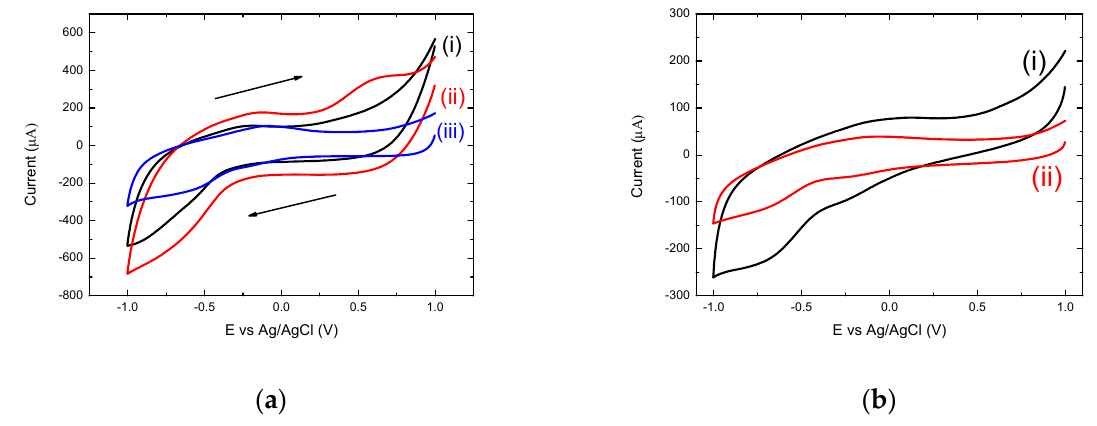
Figure 4. ( a ) CV scans at a scan rate of 0.1 Vs − 1 of (i) a bare graphite/SiO 2 film electrode, (ii) mannan and (iii) OM-(KG) 5 -MOG 35-55 conjugate. ( b ) Depicts the comparison between the CV’s of (i) MOG 35-55 and (ii) MOG 37-55 , both on graphite/SiO 2 in 10 mM NaH 2 PO4, pH 7.0 at scan rate of 0.075 Vs − 1 .